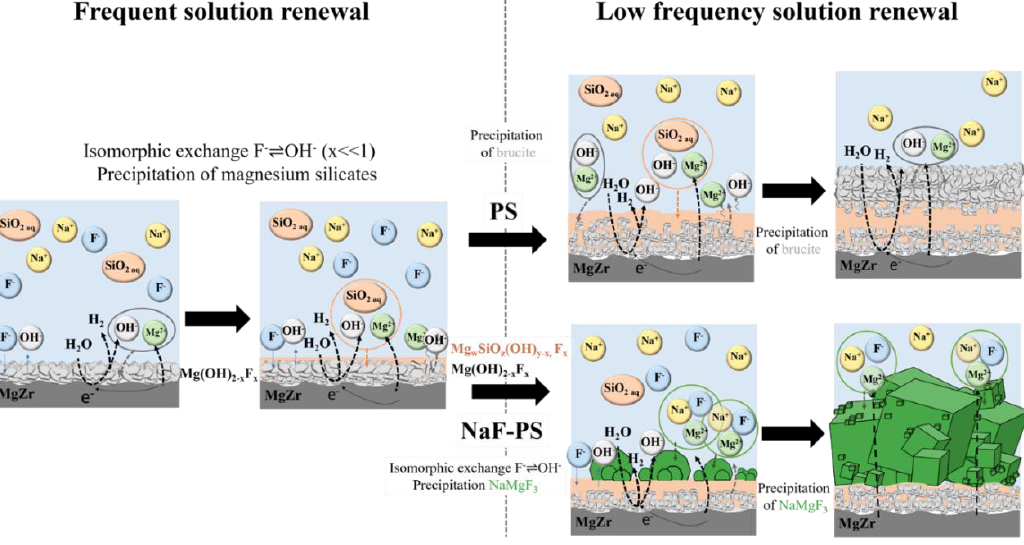
Figure 10. Diagram summarizing the possible processes which can occur during MgZr alloy corrosion in the experimental conditions of the study in PS and NaF-PS solutions extracted from geopolymers without and with NaF, respectively.